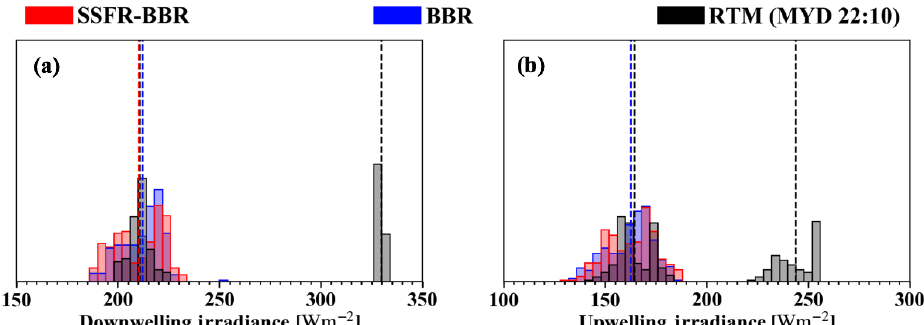
Figure 10. Histograms of broadband (a) downwelling and (b) upwelling irradiance from SSFR–BBR (red), BBR (blue), and MODIS COPs (black, Aqua MODIS at 22:10) RTM calculations on 13 September (below clouds). The mean value of the SSFR–BBR and BBR data is calculated and indicated by red and blue dashed lines. For the RTM calculations, the mean value is calculated for each of the two modes separated by the green solid line and indicated by the black dashed lines.